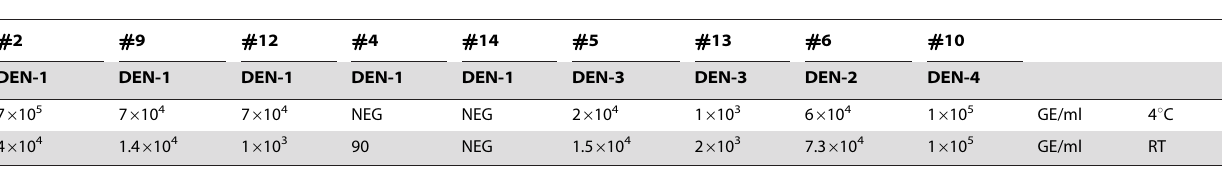
Table 3. Stability of the lyophilized panel of